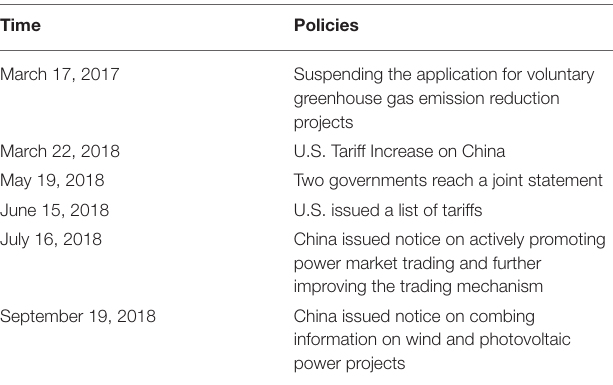
TABLE 5 | Relevant